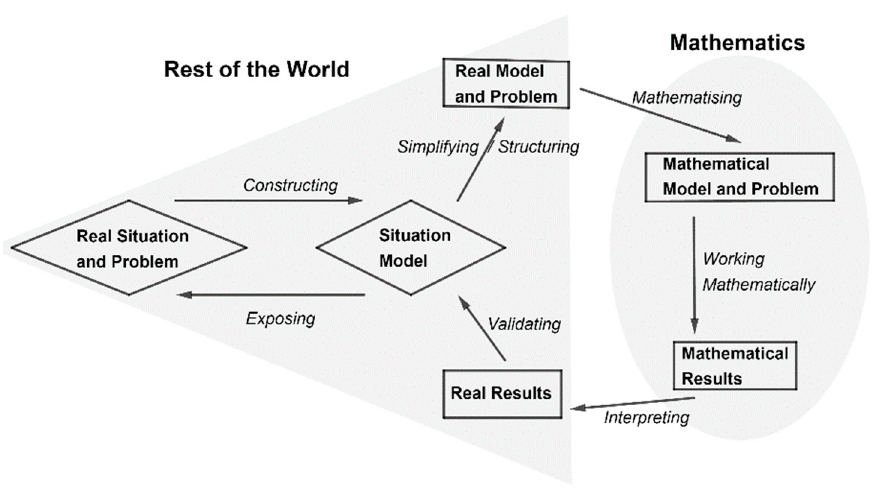
Figure 4. Blum and Leiss’s modeling cycle (source: adopted from [10]).